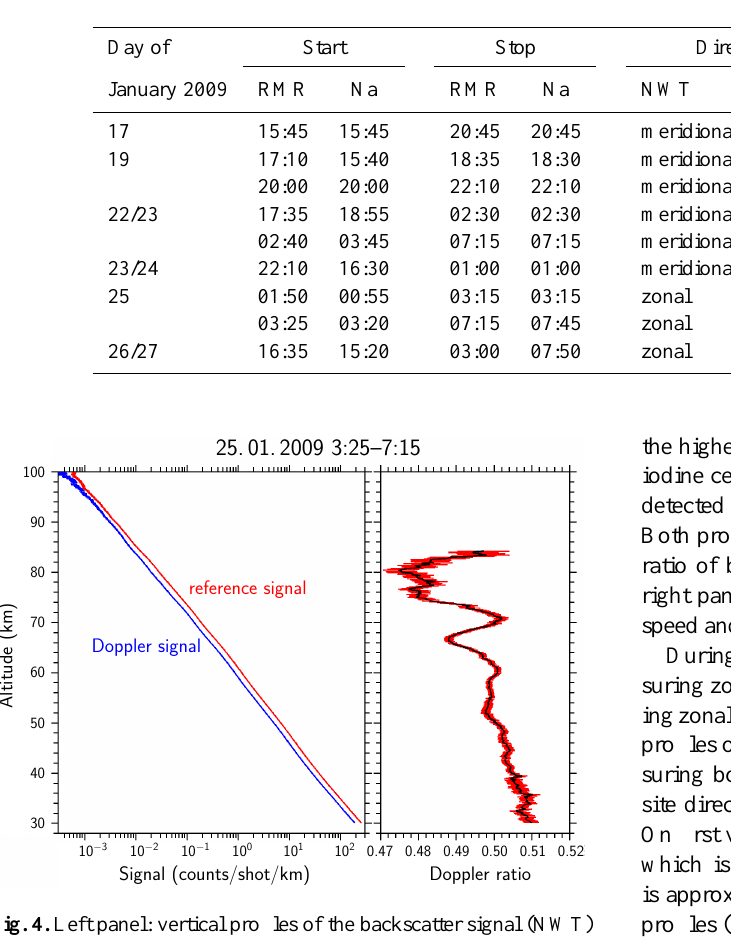
Fig. 4. Left panel: vertical profiles of the backscatter signal (NWT) on 25 January 2009. The red profile shows the reference signal mea- sured in front of the iodine-vapor cell. The blue profile shows the Doppler signal measured behind the iodine cell, which depends on wind speed. Right panel: ratio of both signals (Doppler ratio D 0 ); red horizontal bars indicate measurement